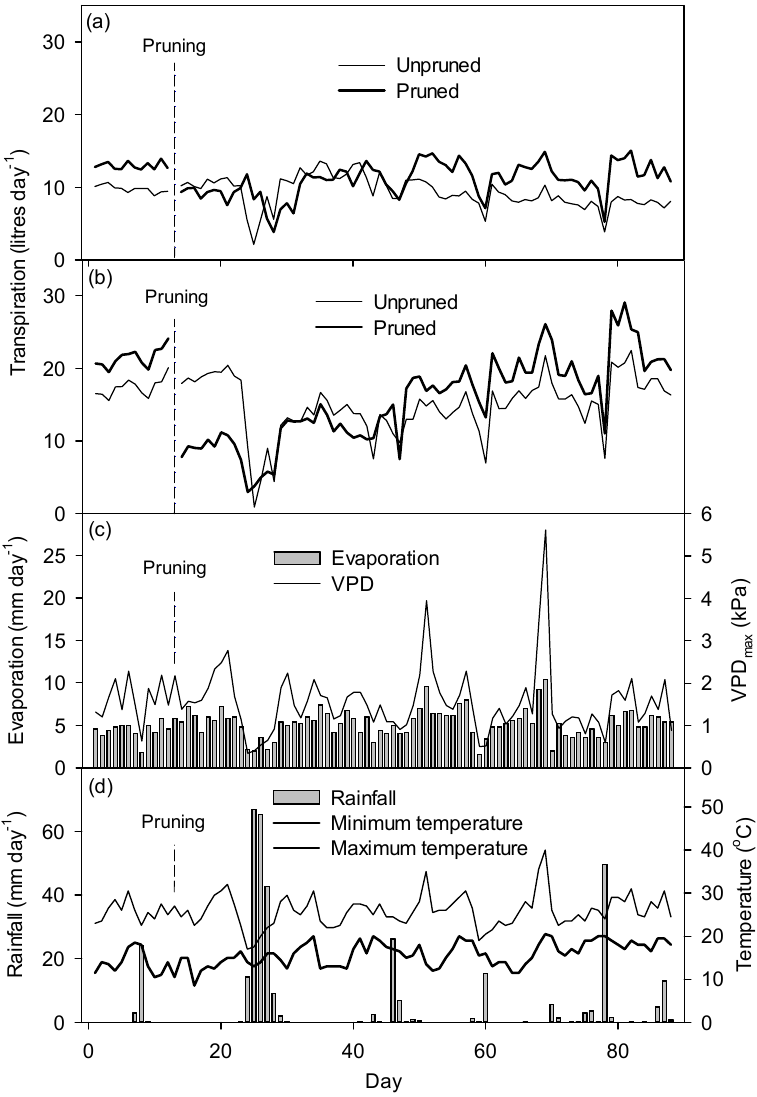
Figure 2. Daily transpiration for unpruned and pruned E. pilularis ( a ) and E. cloeziana ( b